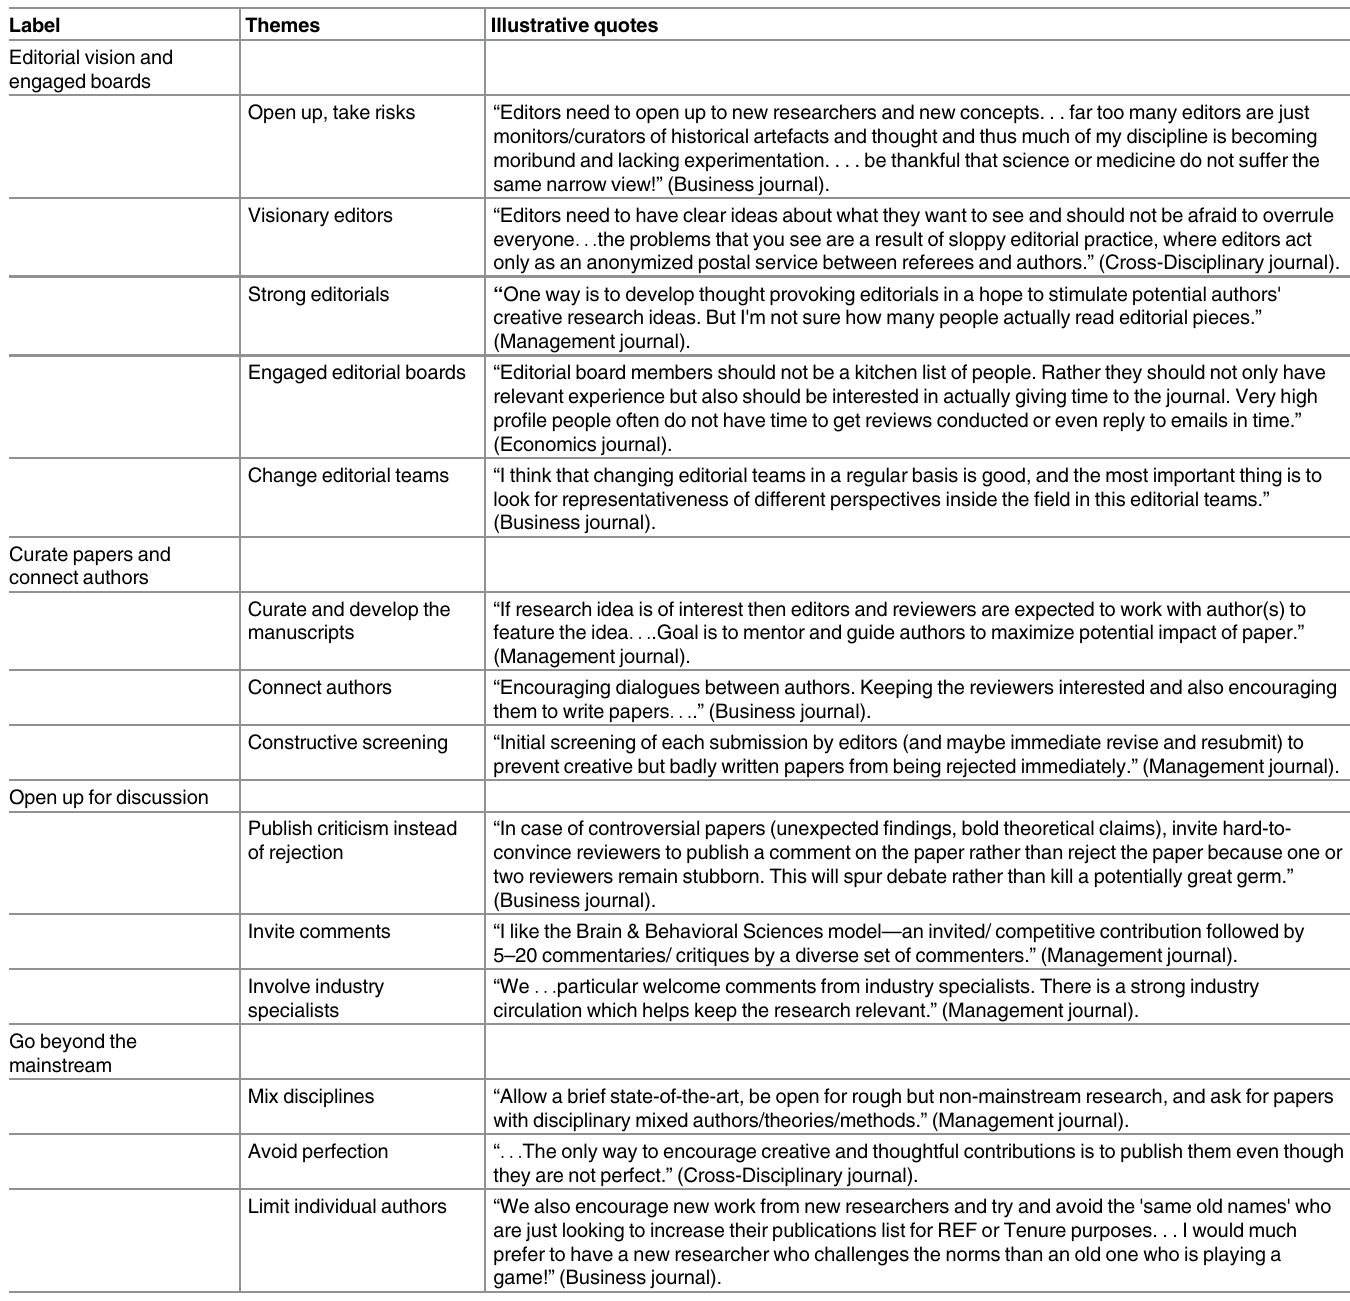
Table 8. How to support creative papers – fourteen themes and illustrative quotes.